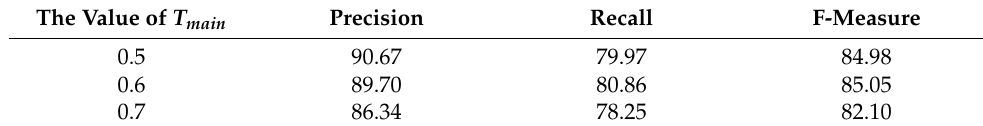
Table 3. Precision, recall, and F-measure of different T main values.